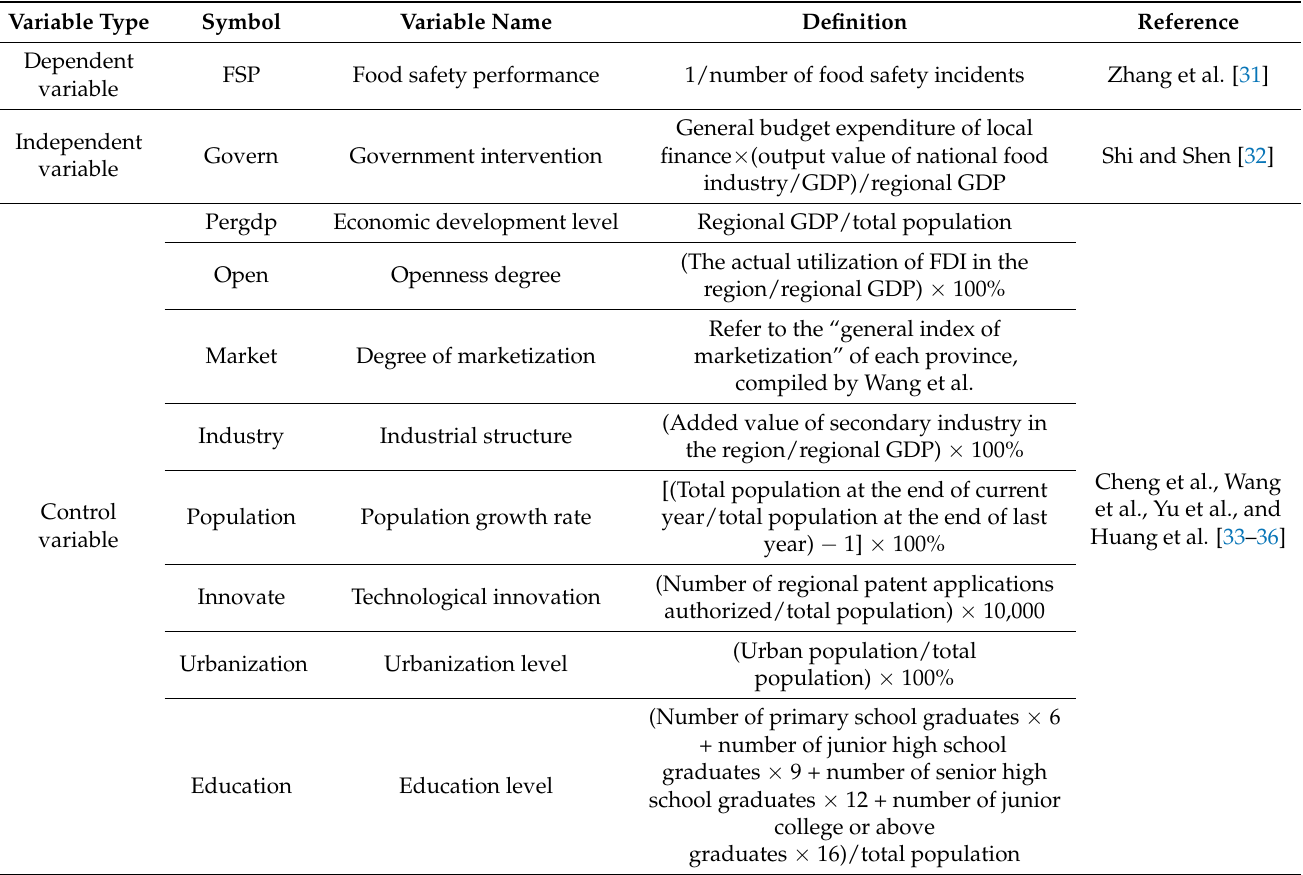
Table 1. Primary variables and